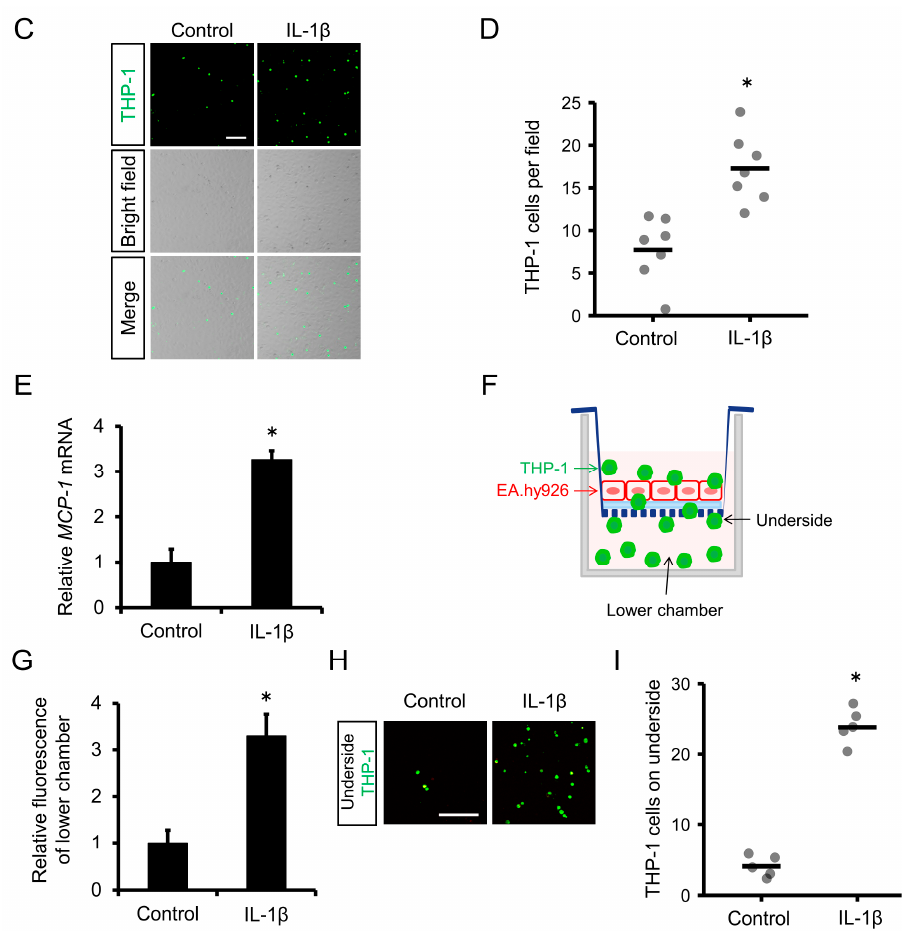
Figure 1. Effect of IL-1 β on monocyte adhesion to endothelial cells and transmigration. ( A ) THP-1 cells were incubated with IL-1 β for 24 h, and Mac-1 expression was examined by flow cytometry. THP-1 cells expressing Mac-1 were defined as CD11b + , CD18 + cells. ( B ) Proportion of cells expressing Mac-1 (CD11b + , CD18 + cells) among live cells. n = 3 in each group. * p < 0.05 compared with the control group. ( C ) Adhesion of THP-1 cells to an EA.hy926 cell monolayer. Fluorescent THP-1 cells and EA.hy926 cells were co-cultured for 1 h after treatment of THP-1 cells with IL-1 β (10 ng mL − 1 ). Scale bar represents 100 μ m. ( D ) Number of fluorescent THP-1 monocytes on the EA.hy926 cell monolayer. n = 7 fields in each group. * p < 0.05 compared with the control group. ( E ) THP-1 cells were incubated with IL-1 β for 24 h, and MCP-1 gene expression was examined by qRT-PCR. n = 3 in each group. * p < 0.05 compared with the control group. ( F ) Schematic diagram of the transmigration assay. ( G ) Transmigration of THP-1 cells through the endothelial layer into the lower chamber was assessed by comparing the relative fluorescence intensity of the upper and lower chambers using a microplate reader. n = 3 in each group. * p < 0.05 compared with the vehicle group. ( H ) THP-1 cells that passed through the endothelial layer and adhered to the underside of the membrane were detected using a confocal microscope. THP-1 cells were labeled with the fluorescent dye BCECF-AM (green). Scale bar represents 100 μ m. ( I ) The number of fluorescent THP-1 monocytes on the underside of the membrane was determined. n = 5 fields in each group. * p < 0.05 compared with the control